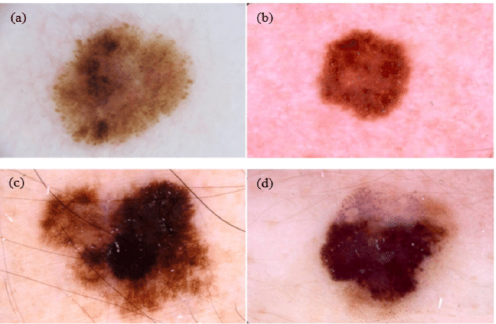
Figure 4. Examples of dermoscopy images: ( a ) and ( b ) are benign lesions; ( c ) and ( b ) are malignant lesions [33].